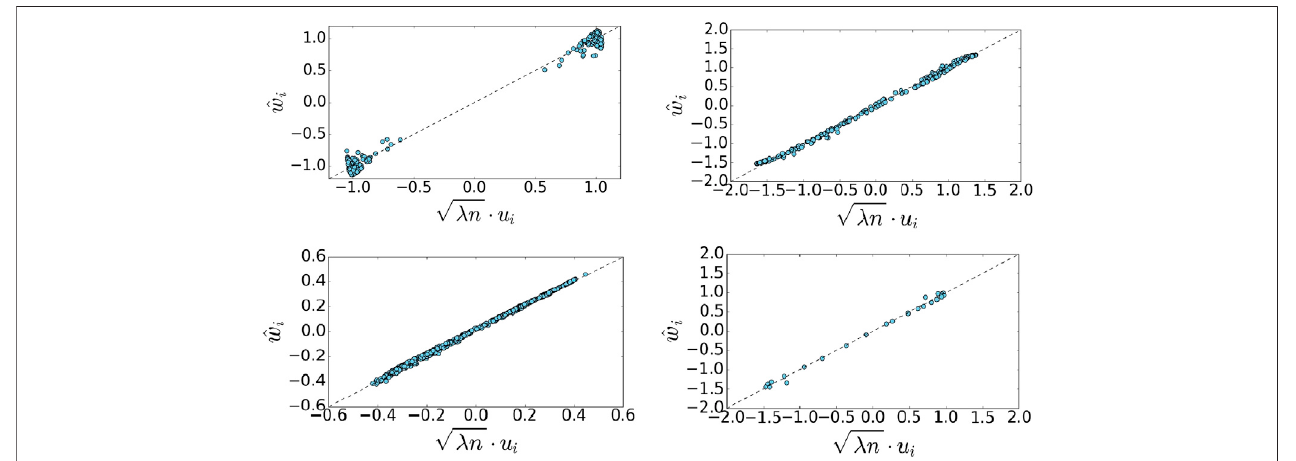
FIGURE7| Scatterplotsofthescaledeigenvectorof P − 1 1,denotedby u ,andtheminimizeroftheapproximatedfunctional(in Eq.3 ),denotedby (cid:13) w .Fromtopleft n to bottom right, results based on data from: two Gaussian clusters, a circle, binary MNIST images and